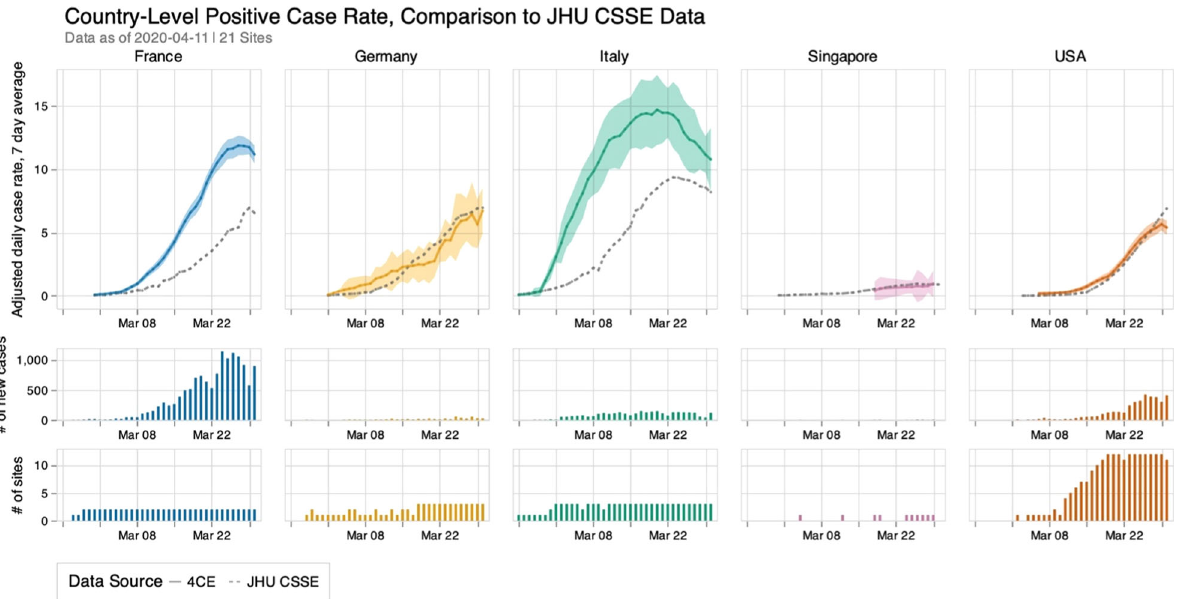
Fig. 2 Adjusted 7-day average new case rate per 100K by country based on 4CE contributors along with 95% con fi dence intervals compared to 7-day average new case rate collected by Johns Hopkins Center for Systems Science and Engineering (JHU CSSE).